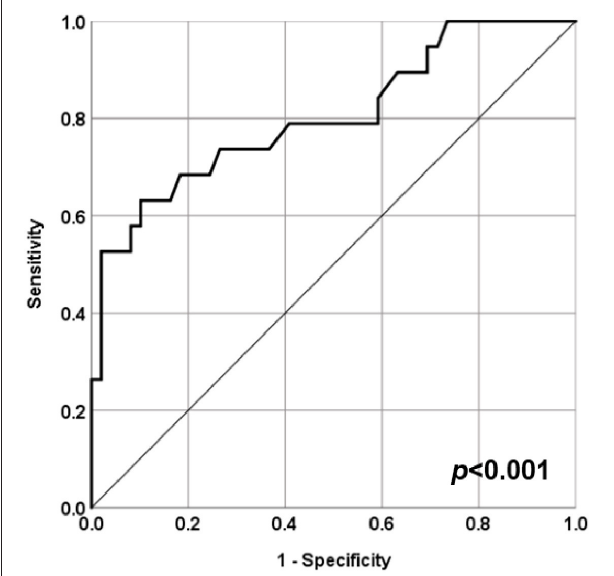
FIGURE 3 | ROC curve for serum C3 levels at admission and central nervous system (CNS) involvement in STEC-HUS patients. ROC curve analysis to evaluate the predictive role of baseline serum C3 levels as risk factor for neurologic involvement in STEC-HUS patients (AUC = 0.804, CI 95% 0.678–0.930, p < 0.001).